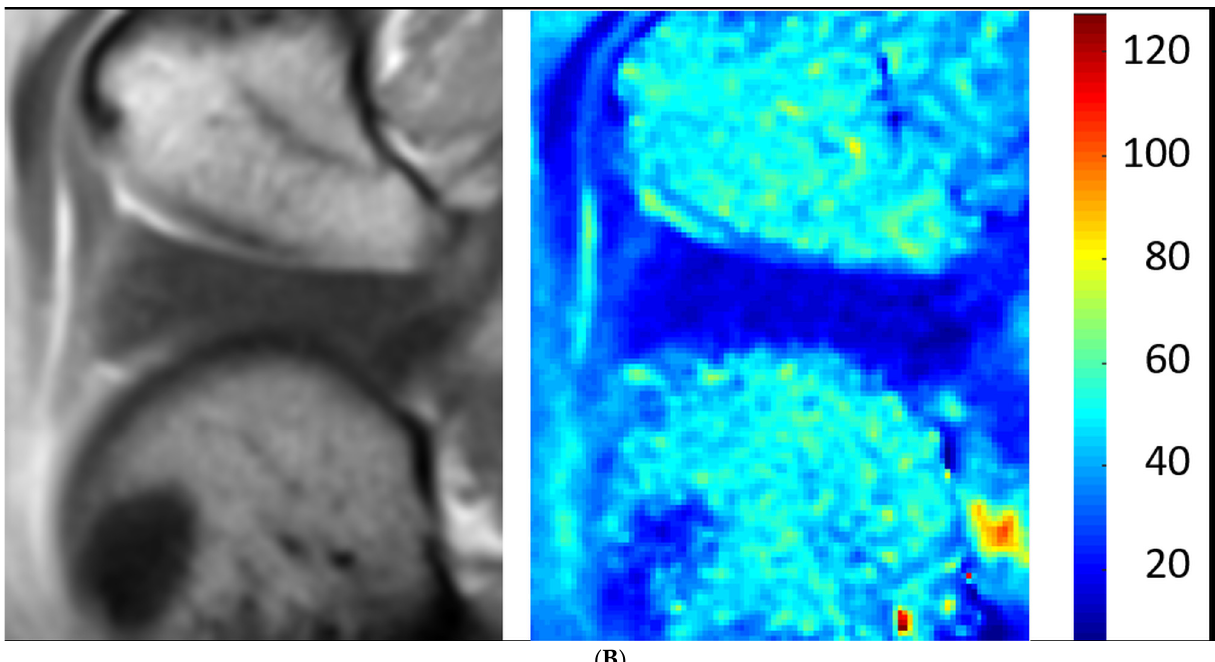
Figure 3. ( A ) Meniscal T2 values in both medial and lateral menisci. There was no significant difference between medial and lateral menisci ( p = 0.13). ( B ) Sagittal magnitude image of a stifle joint and corresponding T2 map. Color chart on the right side represents T2 relaxation times in ms.